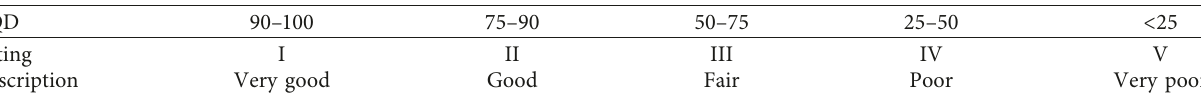
Table 6: Standard ratings of RQD.